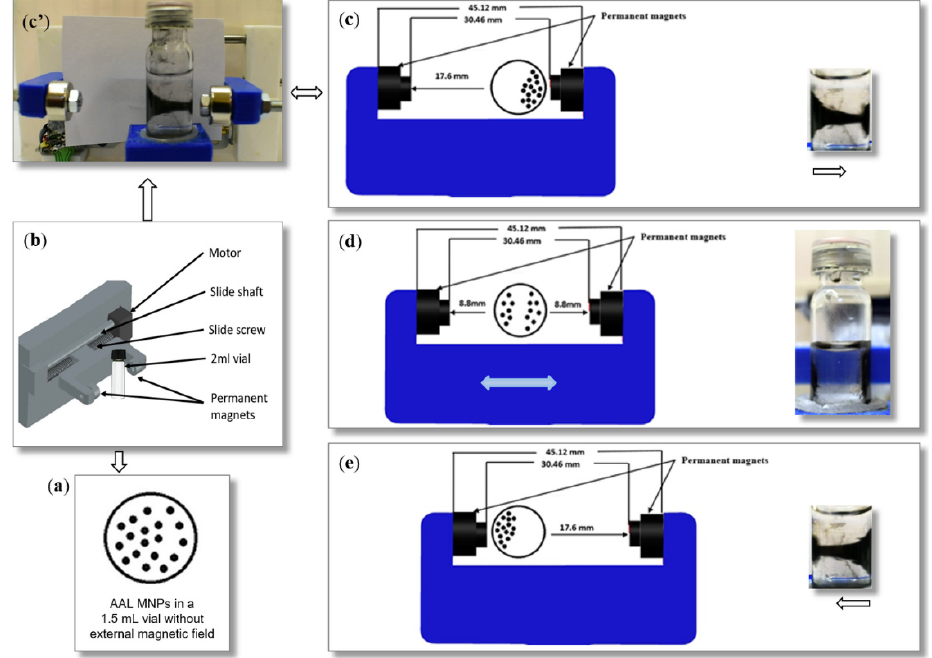
Figure 3. A device for axial magnetic agitation of aspartate ammonia-lyase immobilized on magnetic nanoparticles (AAL-MNPs). The vial containing AAL-MNPs ( a ) was placed in a device ( b , c’ ) capable of moving two permanent magnets in fixed distances along the x -axis, being perpendicular to the y -axis of the AAL-MNP-containing vial. Images ( c , e ) depict the behavior of the MNP-cloud at the two end positions of the movement along the x -axis with the magnets positioned in attraction mode (XM att ); ( d ) shows the mid position (note that negligible portion of AAL-MNPs stuck on the wall of the vial due to the magnetic agitation). The movement frequency is characterized by the mpm (movement per minute) value.